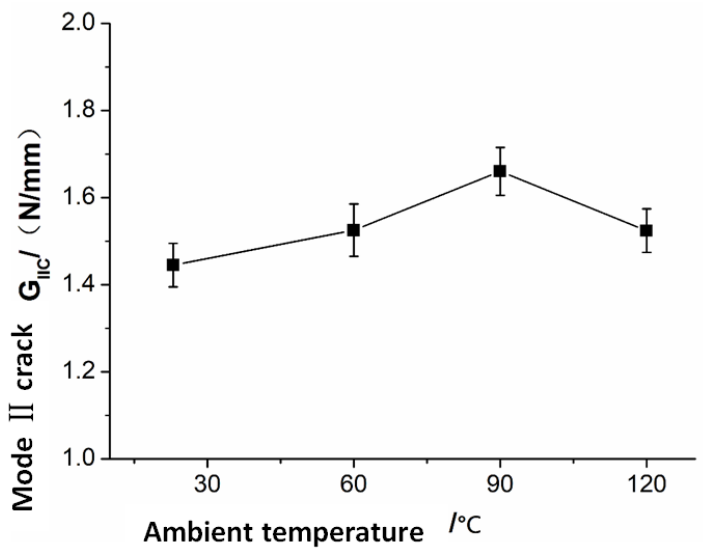
Figure 10. Mode II crack fracture toughness vs. ambient temperature. Figure 10. Mode Ⅱ crack fracture toughness vs. ambient temperature.